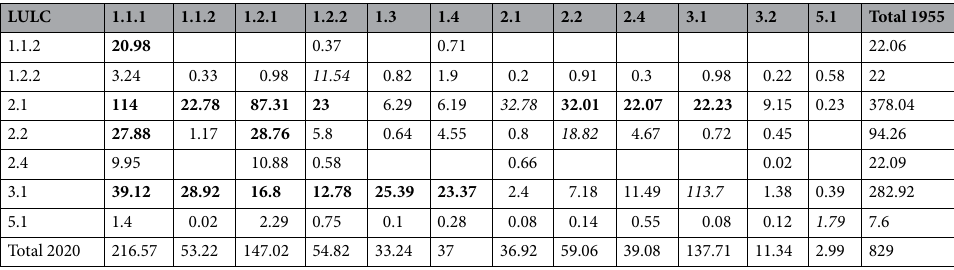
Table 9. LULC change matrix between 1955 and 2020 in the Kestel region (areas in hectares). Significant values are in [bold,